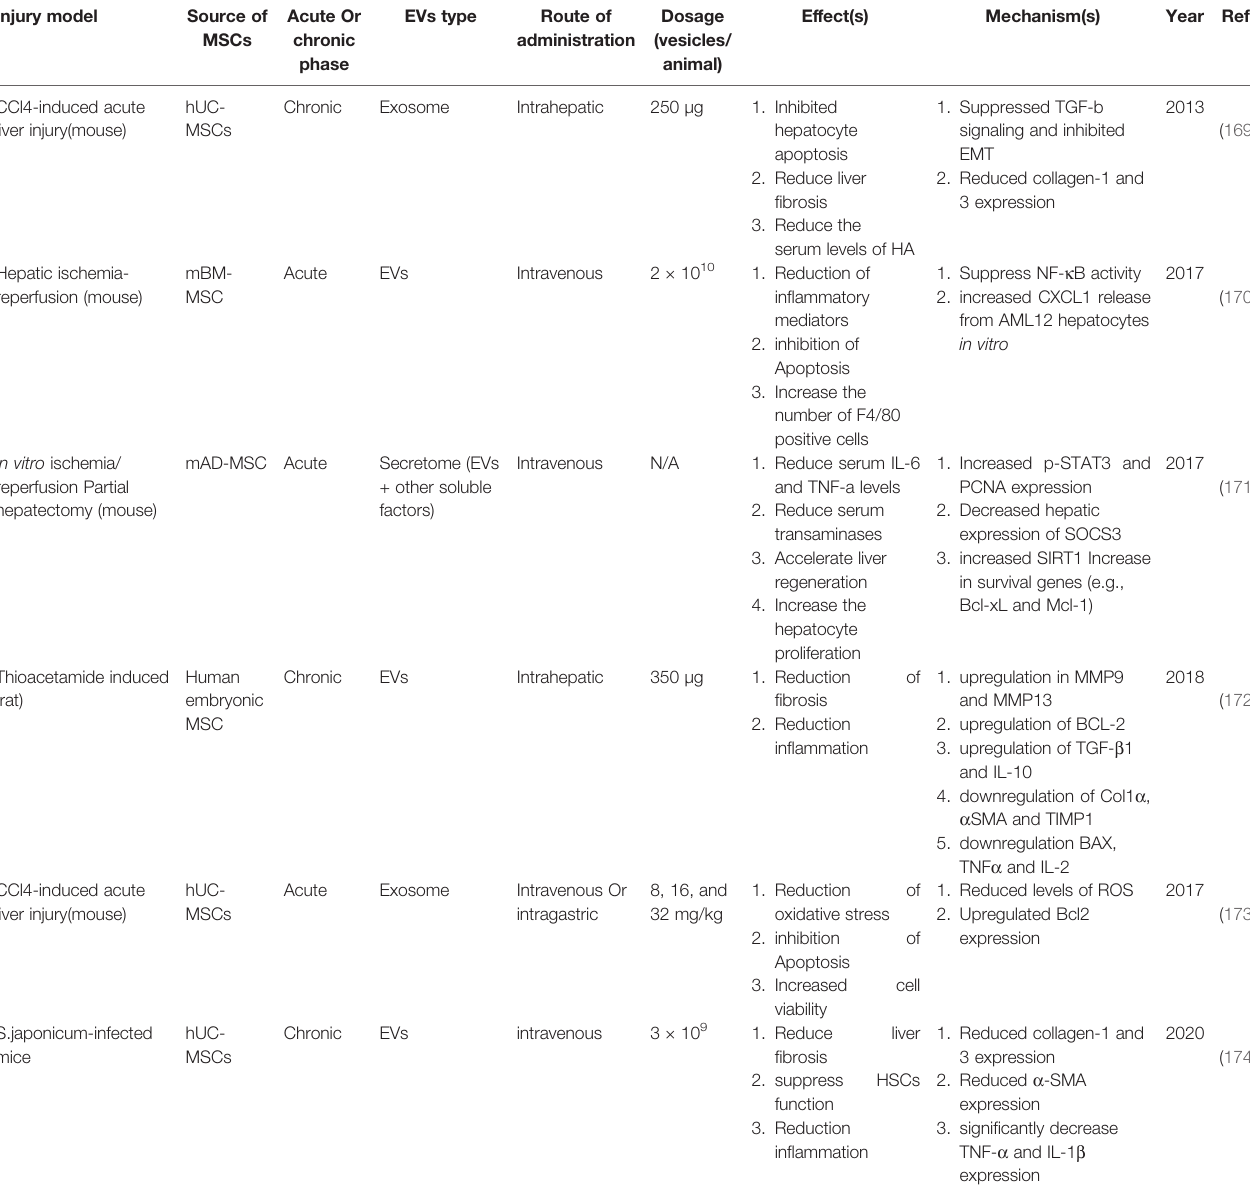
TABLE 4 | Example of studies in the fi eld of MSC-EV application in experimental models of liver injury and their therapeutic